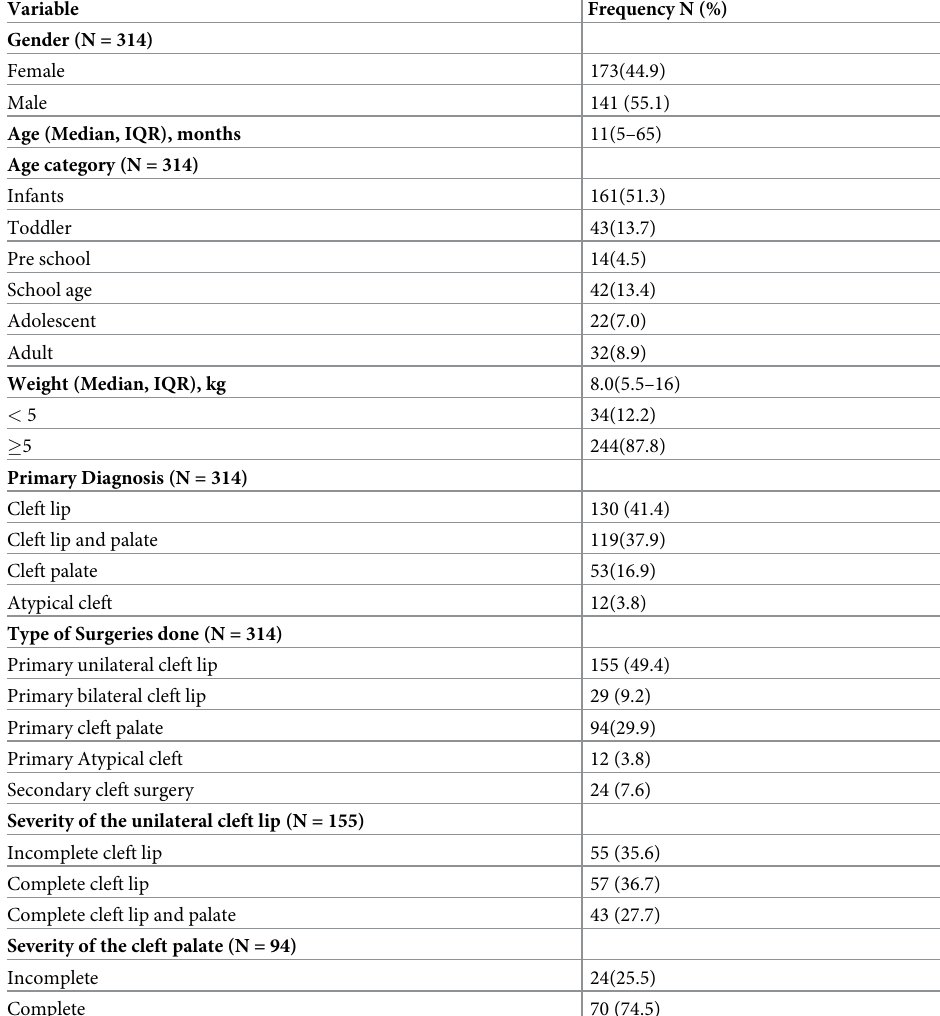
Table 1. Demographic and clinical characteristics of the